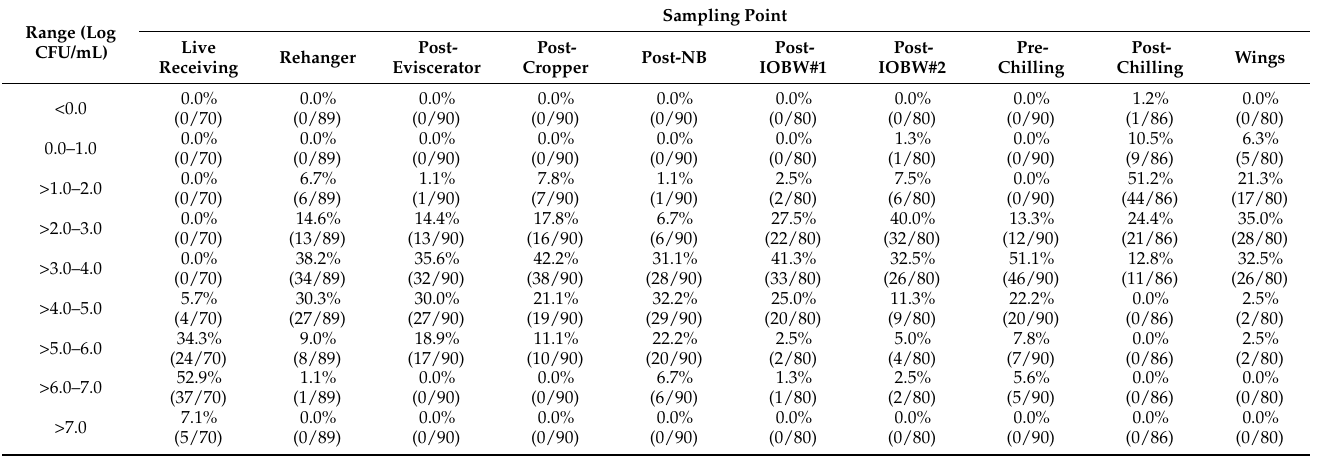
Table A2. Distribution of Enterobacteriaceae counts (Log CFU/mL) on each of the ten sampling locations under reduced process intervention on chicken and part rinses (n = 822